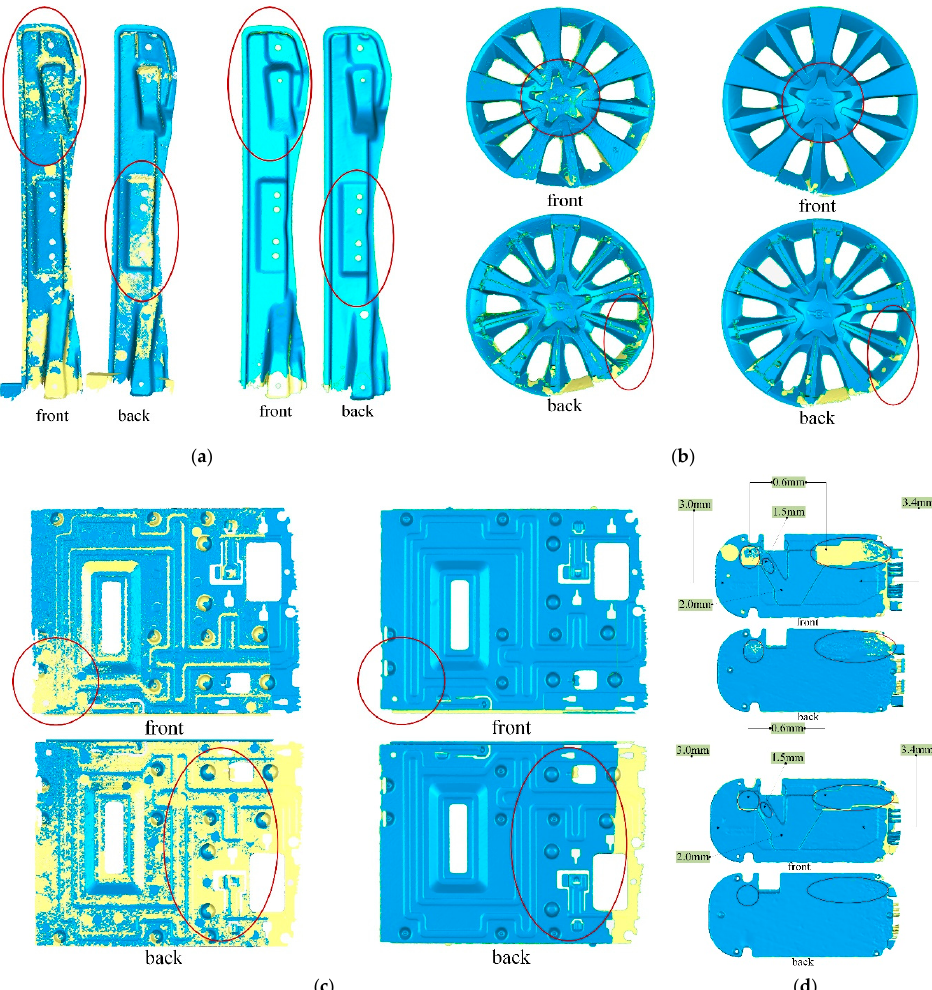
Figure 15. Comparison of scan models from thin products; ( a ) Tubi ć et al. [6] ( left ) and our ( right ) results of the metal bar; ( b ) Tubi ć et al. [6] ( left ) and our ( right ) results of the automobile hub; ( c ) Tubi ć et al. [6] ( left ) and our ( right ) results of the sheet metal part; ( d ) Tubi ć et al. [6] ( top ) and our ( bottom ) results of the metal panel. Sensors 2020 , 20 , x FOR PEER REVIEW